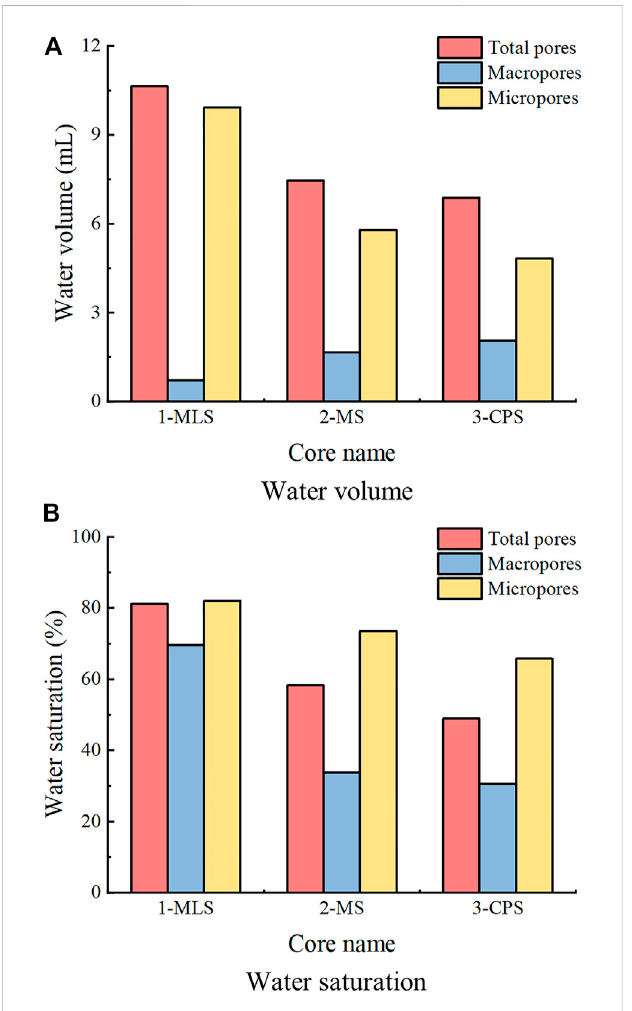
FIGURE 9 Water distribution in different pores for different cores: (A) water volume; (B) water saturation.